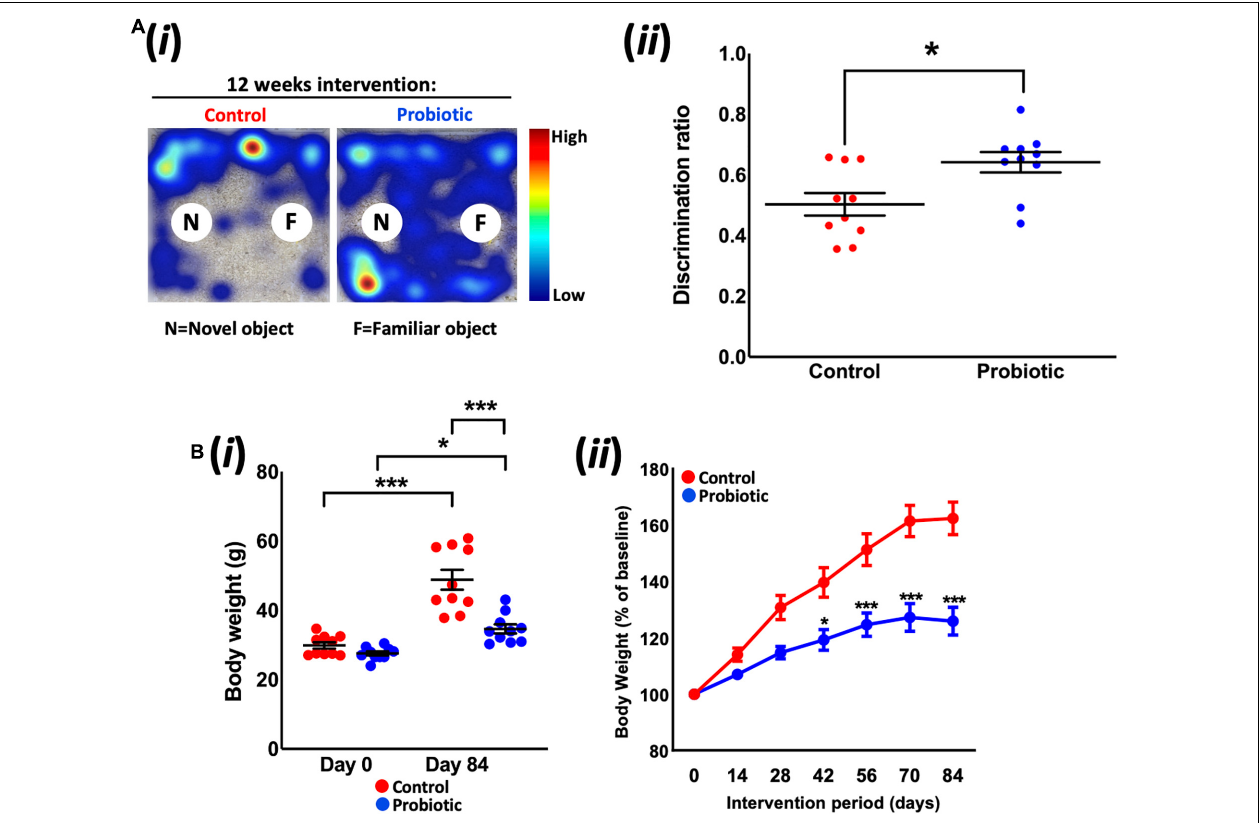
FIGURE 1 | Novel object recognition and body weight. (Ai) Representative heat maps of mouse movements during novel object recognition (NOR) testing and (Aii) the discrimination ratios of the Control and Probiotic groups. (B) Changes in (Bi) absolute body weight and (Bii) percentage body weight over the duration of the study. Data are expressed as mean ± SEM of 10 mice per group. Values of p were determined using unpaired t -test or one-way ANOVA with Holm–Sidak post hoc comparisons where * p < 0.05, *** p < 0.001 or as